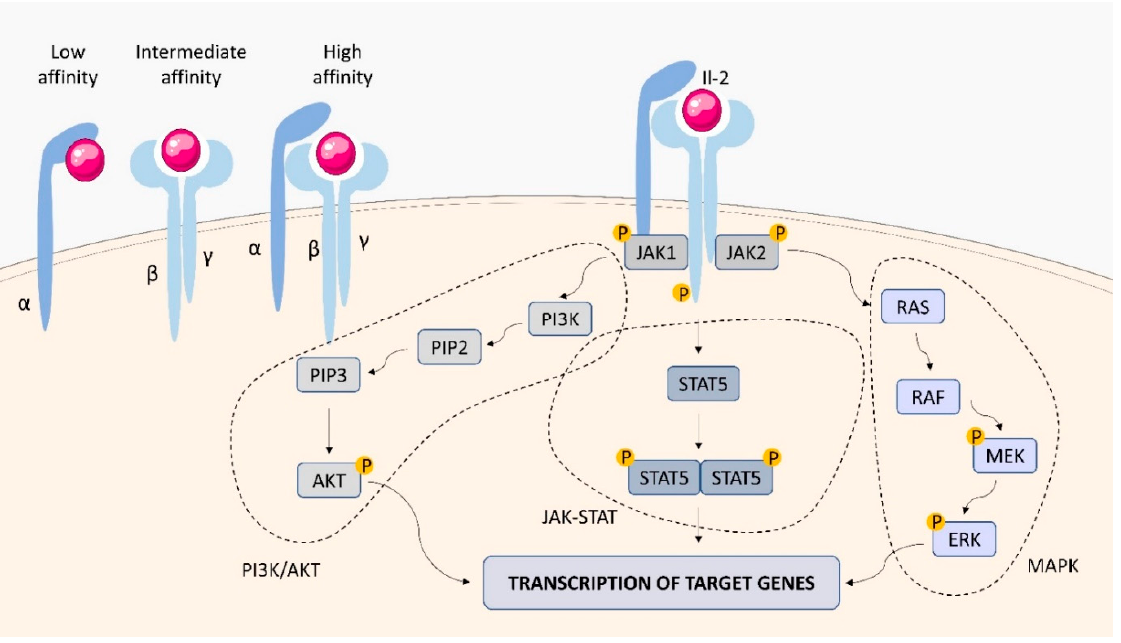
Figure 3. IL-2R structure and signaling. The IL-2 receptor (IL-2R) has three forms, consisting of different combinations of three different chains, IL-2R α (CD25), IL-2R β (CD122), and γ c (CD132). The interaction of IL-2 with IL-2R causes phosphorylation of JAK1 and JAK3, which causes downstream signaling through STAT5. The PI3/AKT and MAPK pathways are activated, which stimulates gene transcription in the cell nucleus, leading to cytokine